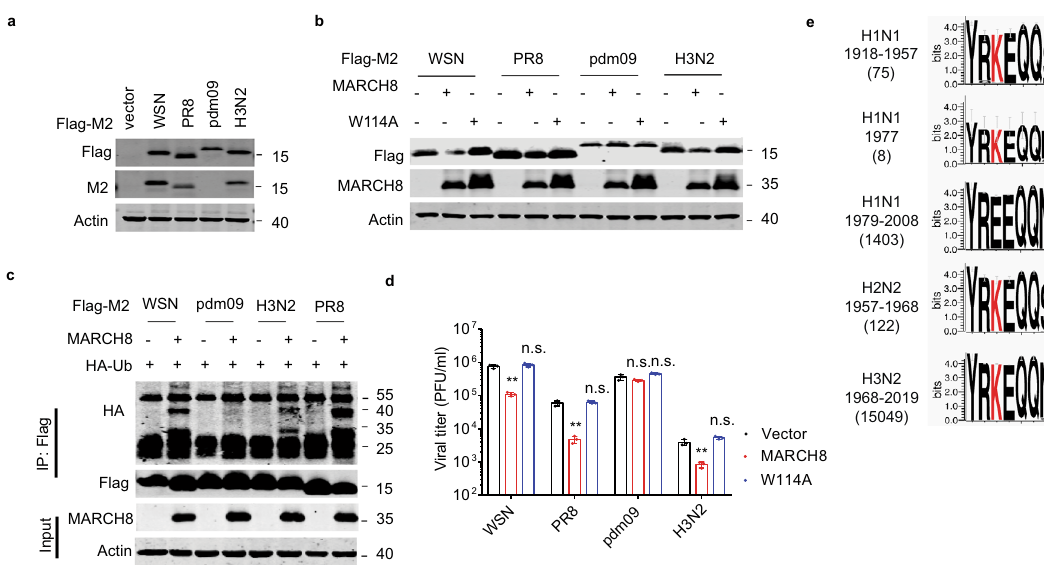
Fig. 8 Evolution of H1N1 virus to escape MARCH8 restriction. a HEK293T cells were transfected with Flag-tagged-M2 from different IAV strains. Expression of M2 was examined in western blots. b Effect of MARCH8 on the expression of M2 proteins from different IAV strains. The HEK293T cells were transfected with different M2 molecules and Vector, MARCH8 or W114A. M2 and MARCH8 were detected with speci fi c antibodies. c Ubiquitination of M2 from different IAV strains by MARCH8. The HEK293T cells were transfected with M2, MARCH8 and HA-Ub. Cell lysates were subject to IP with anti- fl ag antibody, and the IP and input were analyzed by western blotting with antibodies against the indicated targets. d HEK293T cells were transfected with control, MARCH8 or W114A, then infected with WSN virus, PR8 virus, pdm09 virus or H3N2 virus for 24 h (MOI = 0.1). Viral titers in cell culture supernatants were determined by plaque assay. Data shown are the means ± SD ( n = 3 biological replicates). ** P < 0.001; n.s., nonsigni fi cant; unpaired two-tailed Student ’ s t -test, without any adjustments for multiple comparisons. e M2 protein amino-acid sequence logo of IAV isolates. The K78 residues are marked as red. M2 sequences were downloaded from GenBank using the “ collapse identical sequences ” option. Logos were generated using the WebLogo3 online